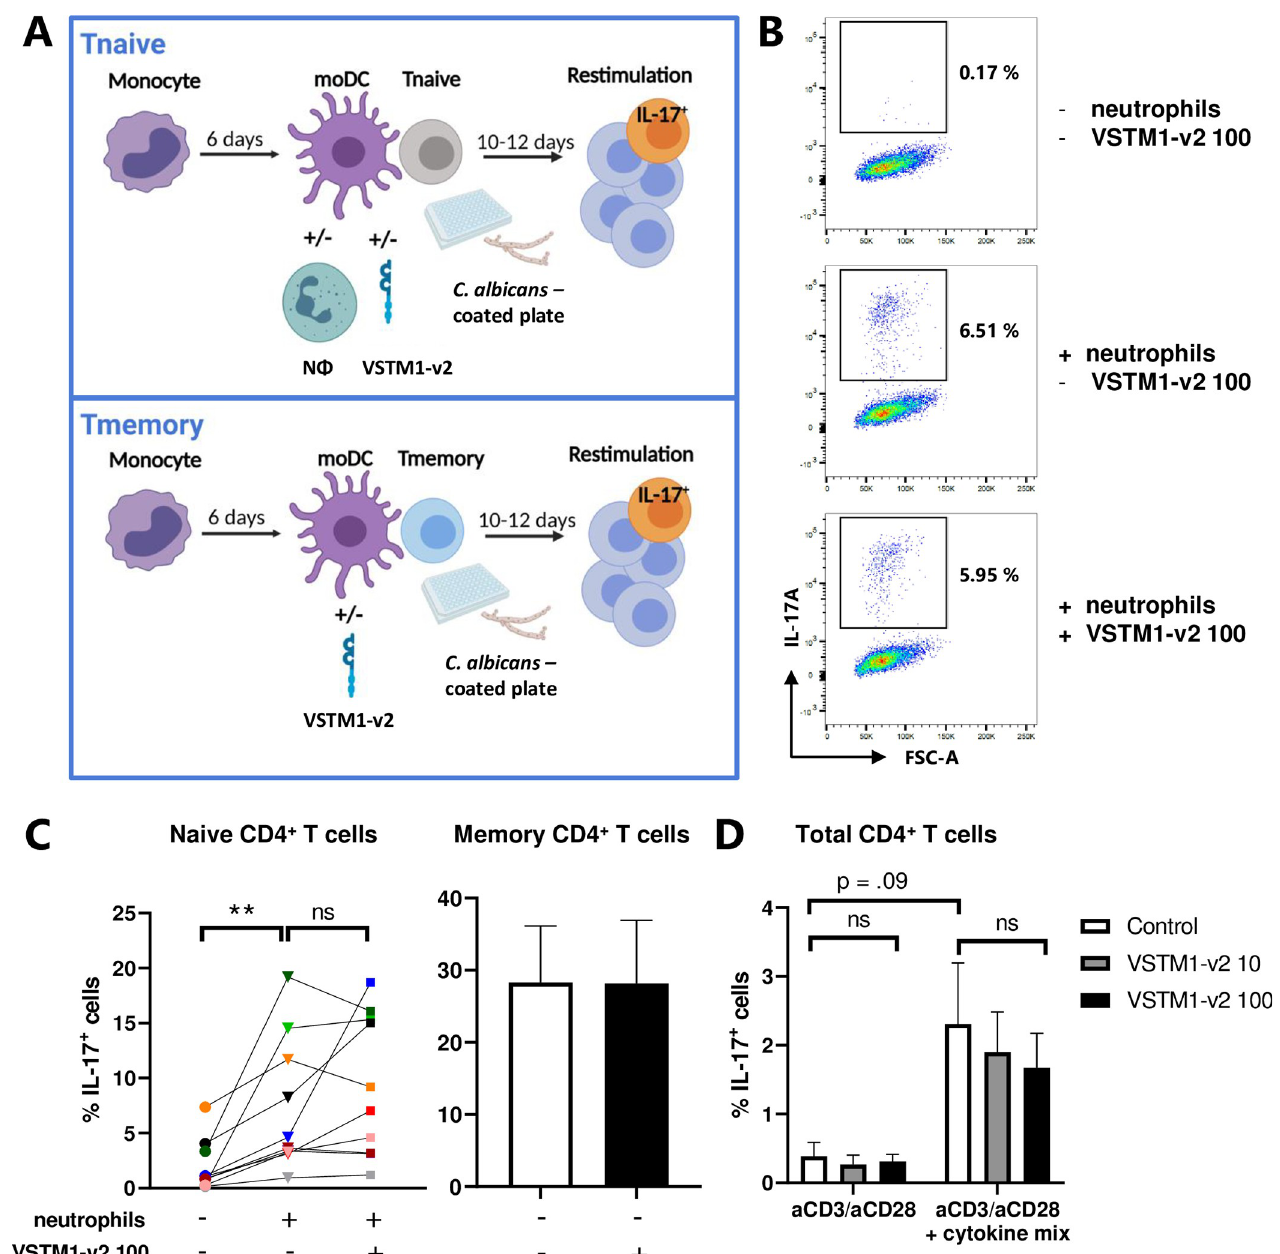
Fig 1. VSTM1-v2 does not enhance Th17 cell differentiation and activation. CD4 + T cells were stimulated by C . albicans -activated moDCs, with or without autologous neutrophils (A-C), or with antibodies and a polarizing cytokine mix (D), with or without addition of 10 or 100 ng/mL VSTM1-v2. Intracellular IL- 17 expression was determined by flow cytometry. (A) Schematic representation of the co-culture system of moDC-driven Th17 cell differentiation and activation. (B) Representative dot plots of the percentage of IL-17 + cells after co-culture of naive CD4 + T cells. The y-axis indicates the fluorescence intensity of the IL-17A staining, while the x-axis indicates the forward scatter (FSC). (C) The percentage of IL-17 + cells after co-culture of naive CD4 + T cells (n = 10), each donor represented by a different color, or memory CD4 + T cells (n = 3; mean ± SD). (D) The percentage of IL-17 + cells after stimulation of total CD4 + T cells with anti-CD3, anti-CD28, and a Th17 polarizing mix, mean ± SD, n = 3. Statistical significance was determined using a Friedman test with Dunn’s correction (C, D). ** p < .01, ns = not significant. Figure A was made using biorender.com.